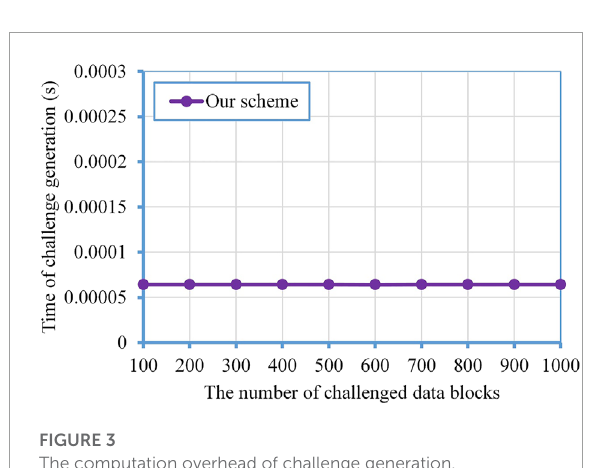
FIGURE 3 The computation overhead of challenge generation.